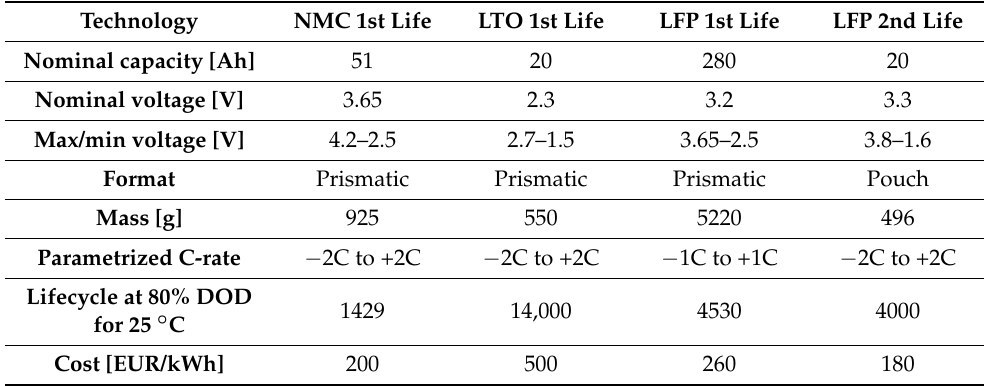
Figure 8. OCV identification result for the selected Li-ion cells in the COF. Table 2. Selected cell specifications to be used in the